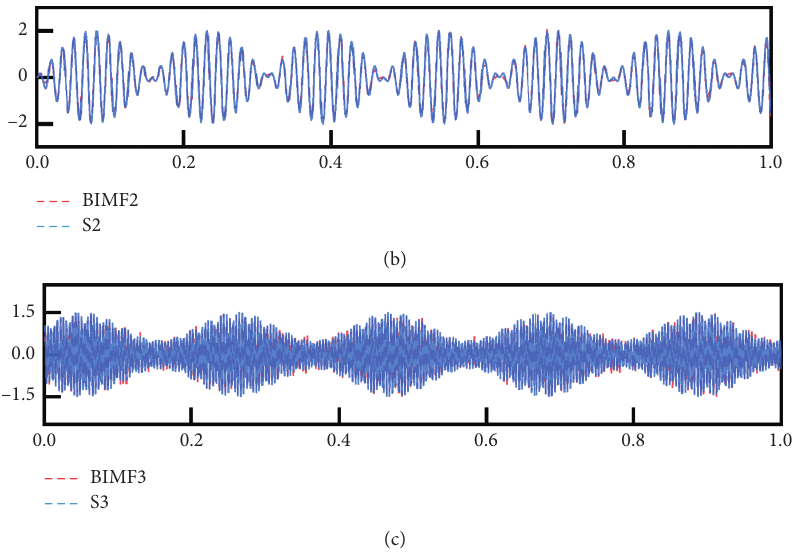
Figure 2: Time-domain comparison of BIMF after VMD.